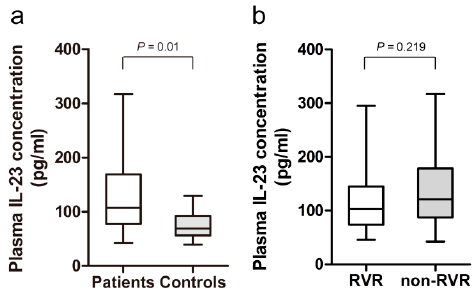
Figure 1. Plasma level of IL-23 was determined by enzyme-linked immunosorbent assay (ELISA). ( a ) Increased plasma level of IL-23 was found in patients with chronic HCV infection ( n = 48) as compared to the healthy controls ( n = 10); and ( b ) no significant difference in the baseline plasma concentration of IL-23 was observed between the patients with chronic HCV infection who showed rapid virological response (RVR, n = 25) and those with non-RVR ( n = 23).